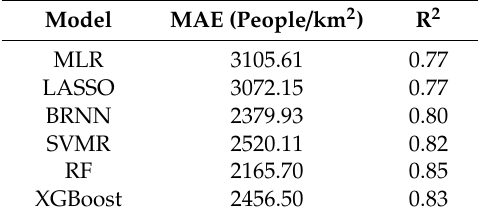
Table 2. Accuracy of population density estimation of the six